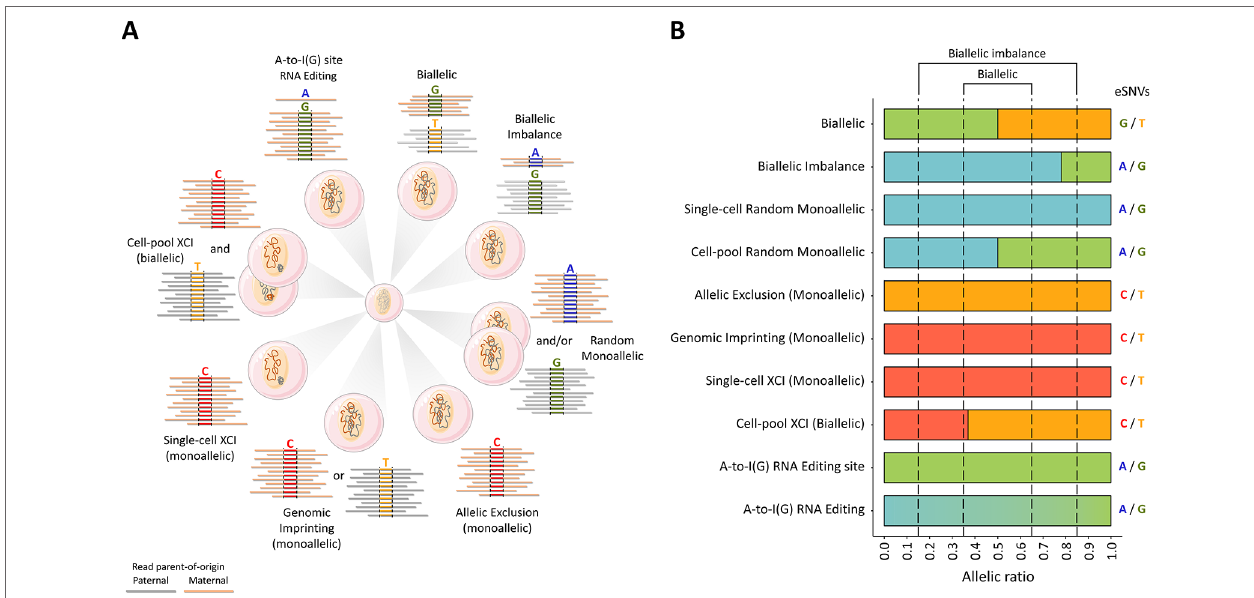
FIgURE 1 | Epigenetic processes involved in allele-specific RNA expression. (A) The differential allele expression of genes best reflects dynamic regulation processes consistent with either an allele being preferentially silenced or an inactive allele being restored. The scenarios are for total steady-state RNA, for which a minimum of 12 reads are depicted across the reference and alternative alleles at hypothetic heterozygote or A-to-I(G) RNA editing sites. The breadth and magnitude of the deviation from the expected strictly biallelic 6:6 read ratio may be ascribed to one of several epigenetic regulatory processes involving compensatory and non-compensatory cis-acting variation epistatic to trans-acting variation. The scenarios are organized clockwise: strictly biallelic, biallelic imbalance, random monoallelic, allelic exclusion, genomic imprinting, single-cell X-chromosome inactivation (XCI), cell-pool XCI, and RNA editing. Up to 30% of all tested protein-coding autosomal genes are subjected to clonal (mitotically) stable, random monoallelic expression, which can be either coordinated or uncoordinated (Gimelbrant et al., 2007; Savova et al., 2016a; Savova et al., 2016b; Vigneau et al., 2018). Up to 23% of genes linked to the X-chromosome are expressed from the inactive X (i.e., XCI escapee genes) and, therefore, are biallelically expressed in each female somatic cell (Tukiainen et al., 2017). About 2.6 million ribonucleotide sites genome-wide are known to be subjected to A-to-I(G) RNA editing (Ramaswami and Li, 2014). Thus, the human tissues are, in essence, expression mosaics due to epigenetic-, cis-, and trans-acting covariates. (B) The extent of the allele-specific expression for the scenarios illustrated in panel (A) using RNA-Seq reads across SNVs in genes known to be subjected to the indicated regulatory processes. WRB (biallelic) (Alves Da Silva et al., 2016; De